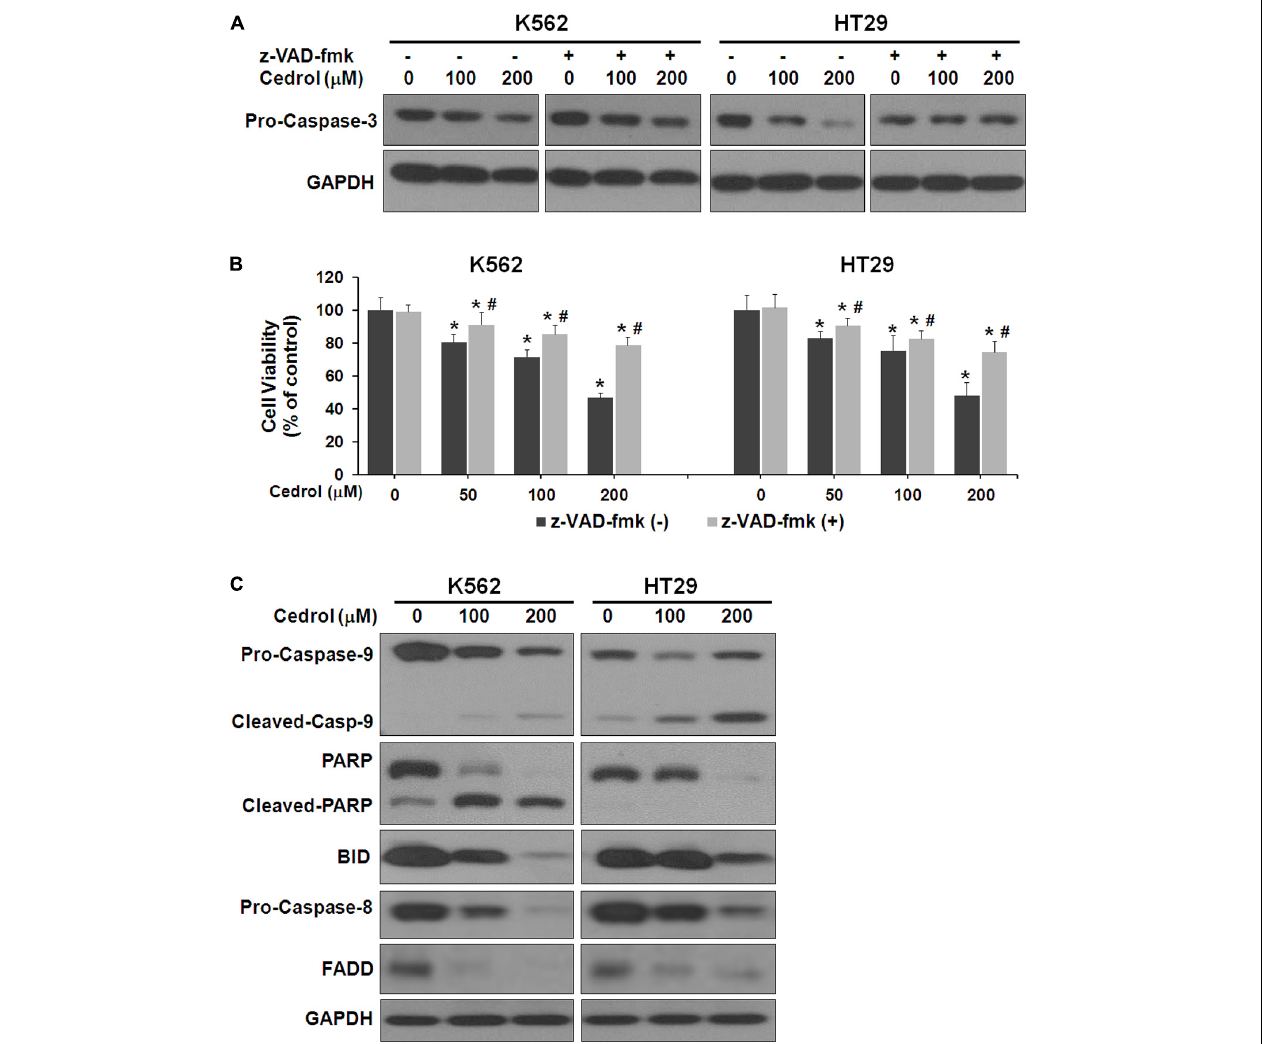
FIGURE 2 | Cedrol induced caspase activation in K562 and HT29 cells. (A) Cells were treated with z-VAD-fmk (50 µ M) for 1 h in serum-free media. Cells were then washed with either VH or cedrol in serum-free media for 18 h. Protein was isolated, and Western blotting was performed. (B) Cells were treated with or without cedrol in combination of z-VAD-fmk (50 µ M) for 48 h. Cell viability was assayed as described in Materials and Methods. (C) K562 and HT29 cells were treated with VH or cedrol for 18 h. Total cytosolic proteins were isolated, and Western blotting was performed.